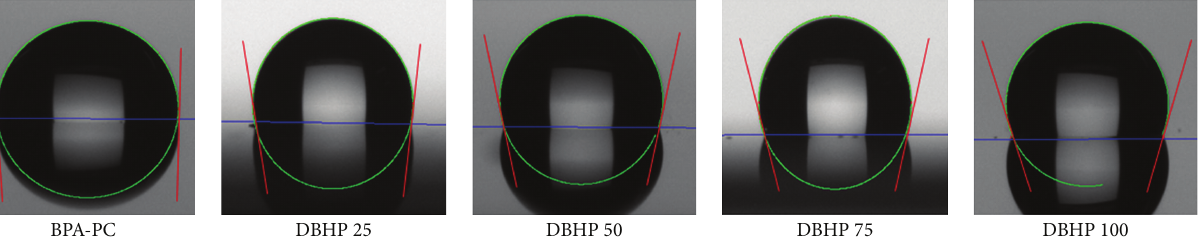
Figure 5: Image of water drop on the polymers’ film.